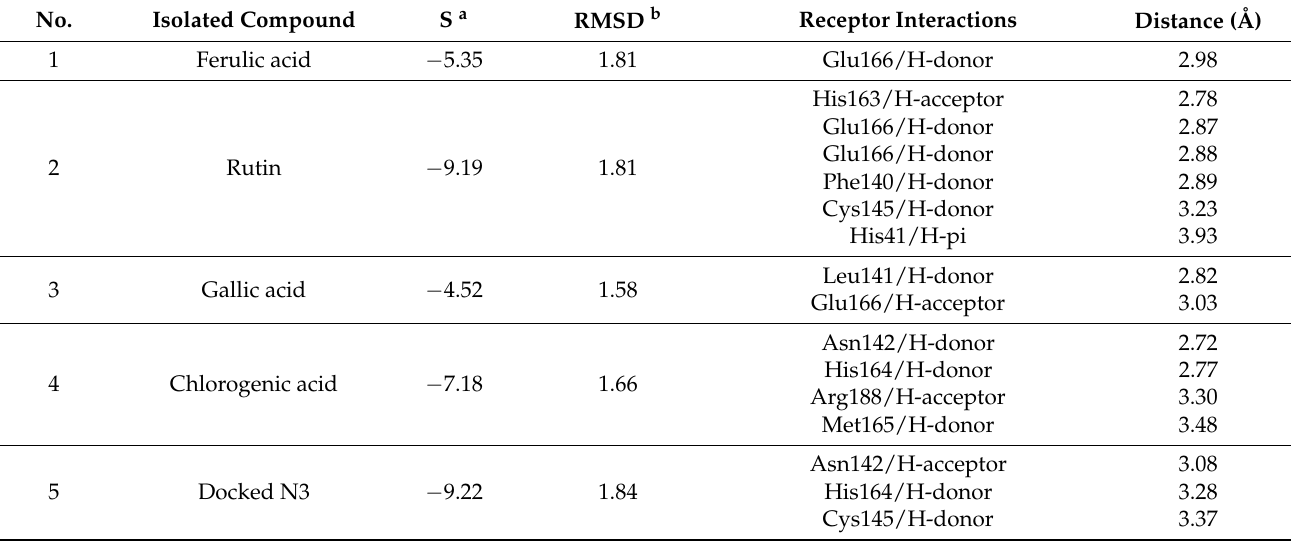
a S : the score of a ligand inside the binding pocket (Kcal/mol). b RMSD : The Root Mean Squared Deviation between the predicted pose and the crystal